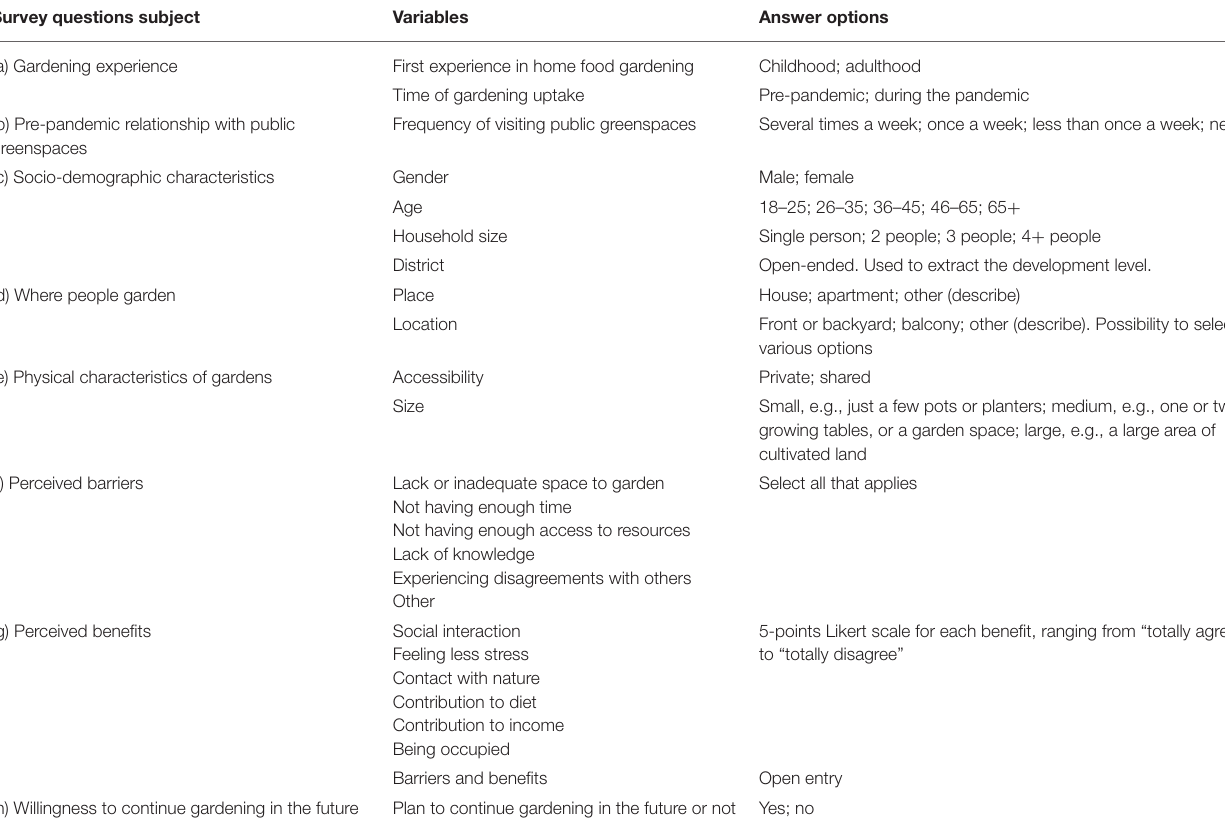
TABLE 1 | Themes and variables with answer options derived from the online survey. Survey questions